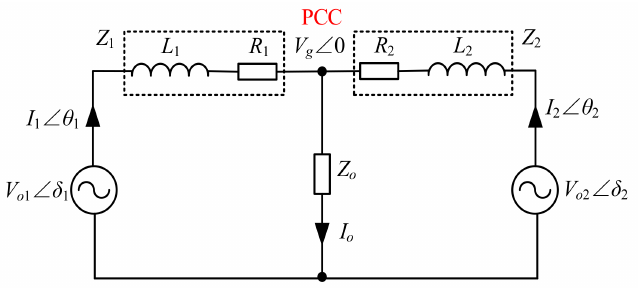
Figure 2. Equivalent circuit of two inverters operated in parallel (one